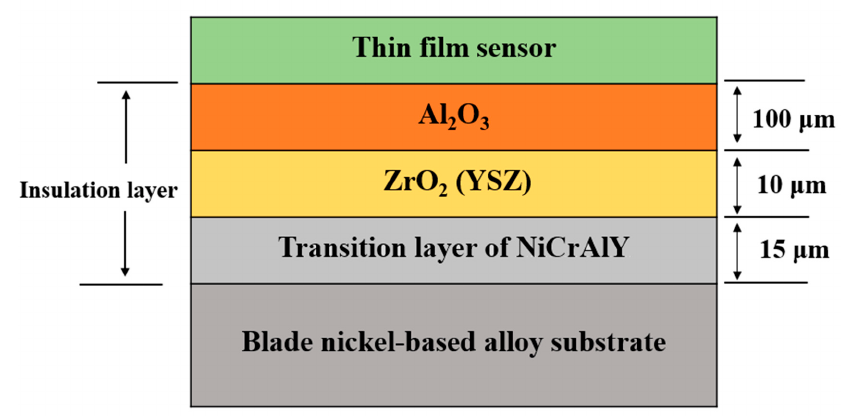
Figure 2. Structure of the composite insulating layer.